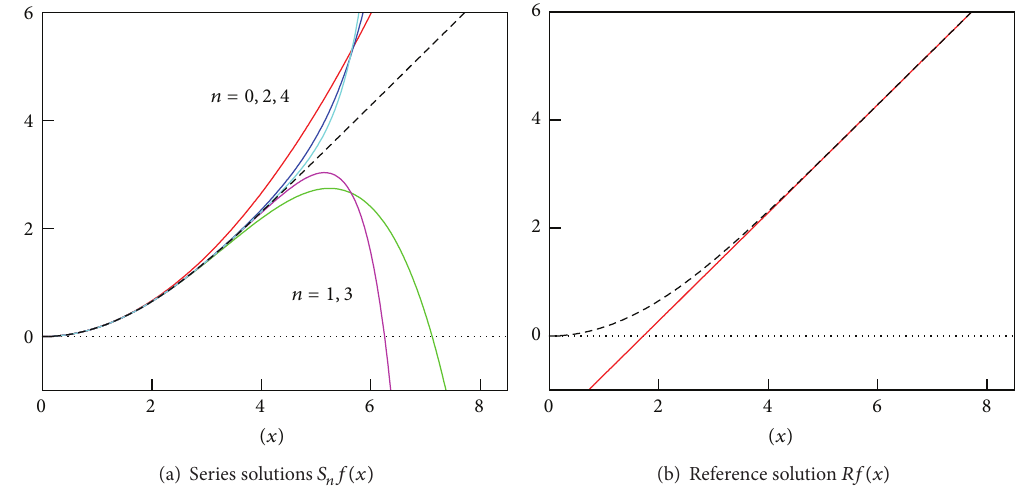
Figure 1: Approximations of the series solutions 𝑆 𝑛 𝑓(𝑥) for each 𝑛 = 0, 1,2, 3, 4 in (a) and the reference solution 𝑅𝑓(𝑥) in (b).